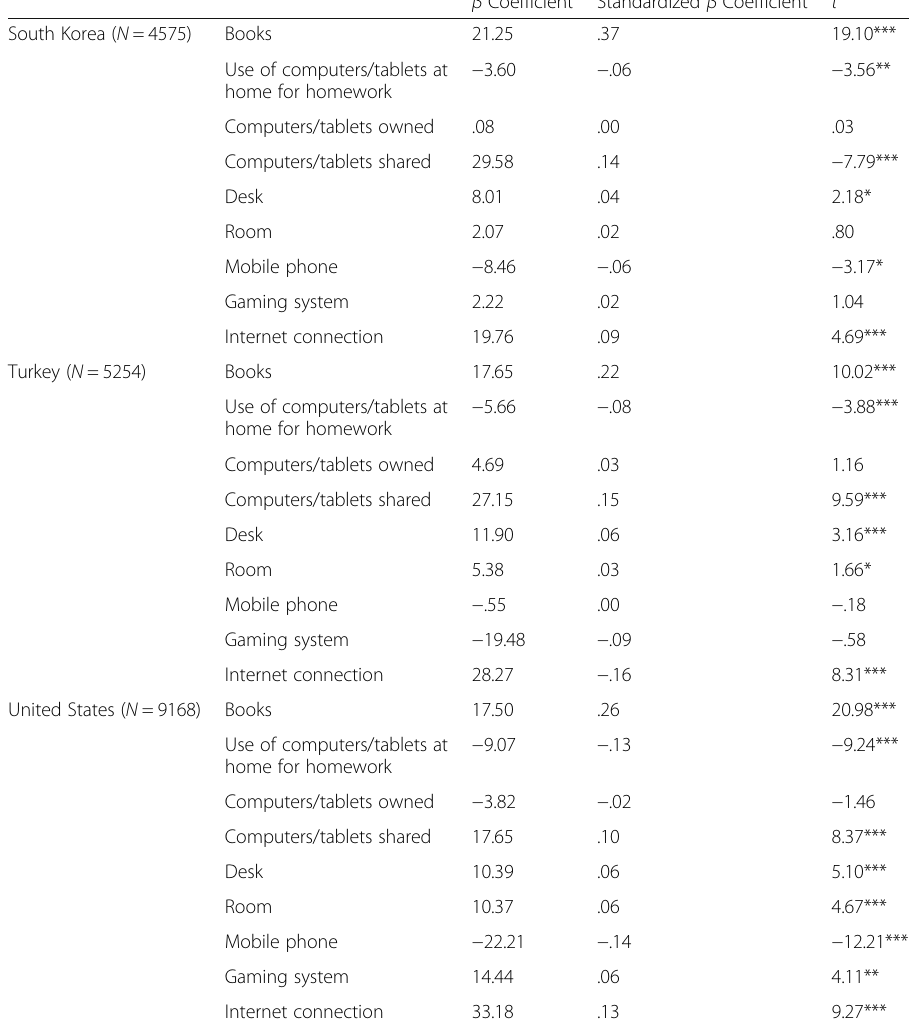
Table 7 Multiple regression results with home resources items as predictors by countries β Coefficient Standardized β Coefficient